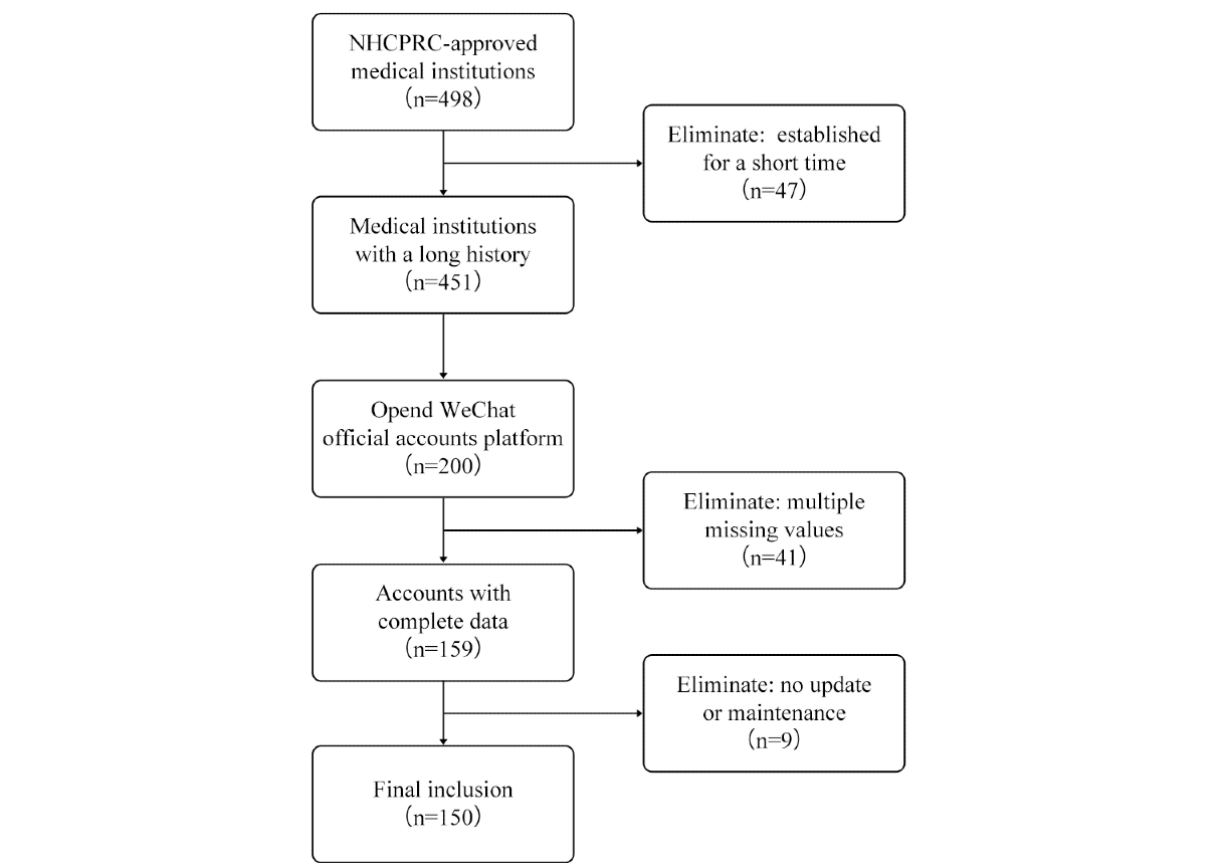
Figure 3. Flowchart of the selection process for WeChat official accounts of assisted reproduction technology centers. NHCPRC: National Health Commission of the People’s Republic of